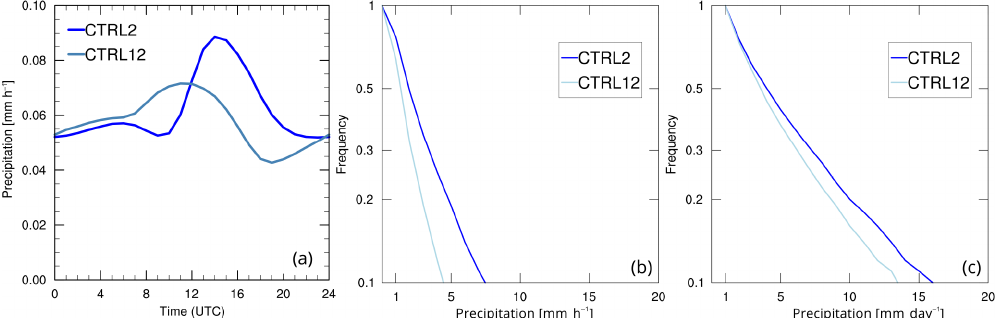
Figure 8. (a) Average diurnal cycle of precipitation over land, (b) cumulative frequency-intensity distributions of daily-maximum 1h pre- cipitation, and (c) daily